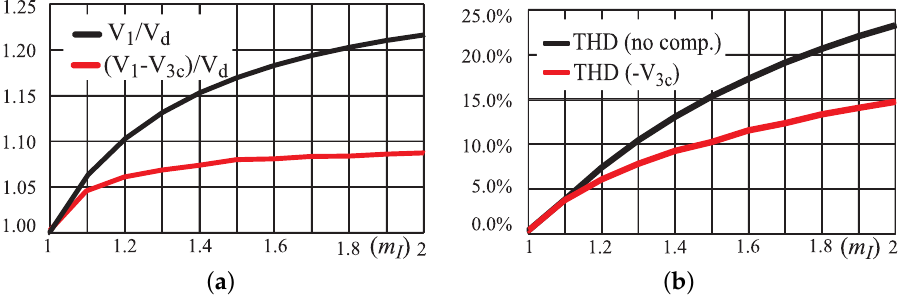
Figure 9. ( a ) First harmonic voltage gain and ( b ) THD vs. m I , both without- (upper curve) and with third harmonic compensation (bottom